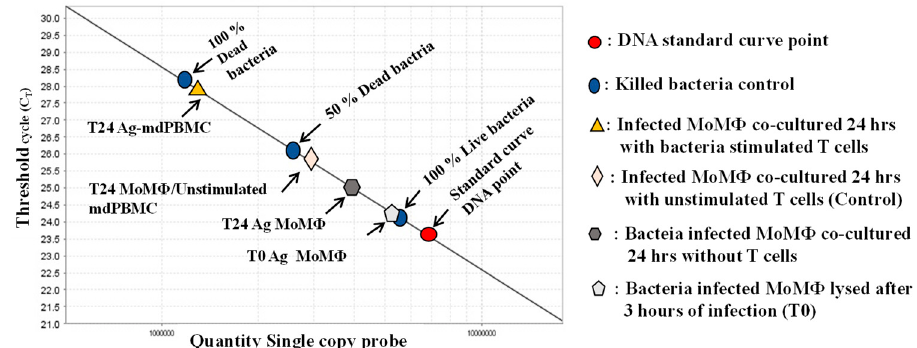
Figure 3. Illustration of the quantitative PCR method using propidium monoazide and a single copy gene from Map , F57, or lpqT (Rv1016c) from Mbv BCG in order to distinguish live from dead bacteria. A standard curve is generated from a single copy gene. A known concentration of DNA from live bacteria (100%), a mixture of 50% live bacteria and 50% dead bacteria, and 100% dead bacteria are used to show the range of sensitivity for quantifying the proportion of intracellular bacteria killed by CD8 CTL. Controls include the percent of live bacteria present in MoM Φ 3 h after uptake by MoM Φ , 24 h after uptake, and 24 h after incubation of MoM Φ with unstimulated mPBMC. Covalent binding of PMA to DNA is incomplete, allowing for a comparison of the differences in the percent of DNA from live and dead bacteria from infected MoM Φ target cells in relation to the DNA detected in the 100% live, 50% live and 50% dead, 100% dead control